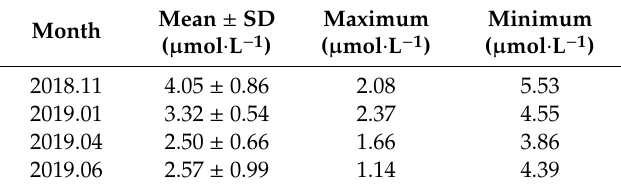
Figure 3. Seasonal changes in urea illustrated using a box diagram for coastal water of the ZJB (data were from November 2018 to June 2019). (The lines and squares, lower and upper edges, and lines and crosses in- or outside the boxes represent median and mean values, 25th and 75th, < 99th and > 1th, and minimum and maximum values of all data, respectively; Symbols see Figure 3). Table 2. Seasonal urea concentration: mean, maximum, and minimum values in